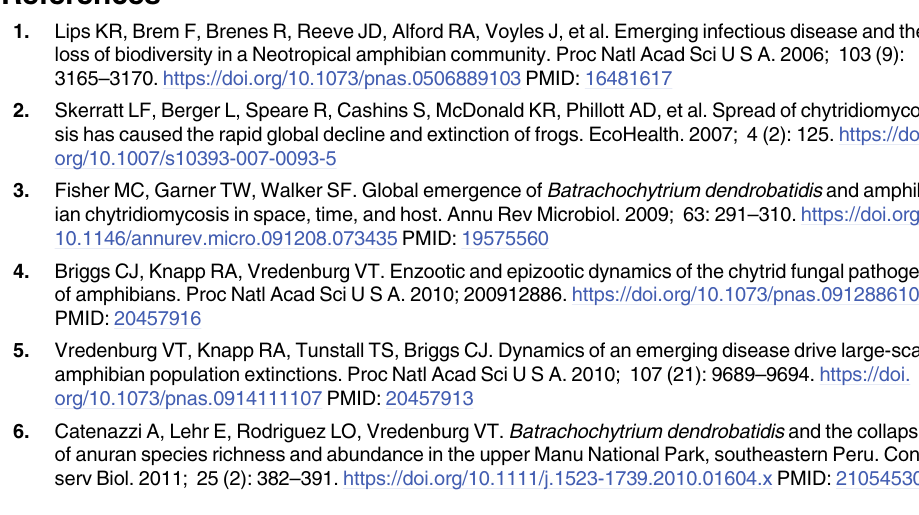
S4 Table. ENMeval models results. S5 Table. Variable contributions to Bsal distribution model. S6 Table. Salamander species of Mexico, range, IUCN status, and relationship with Bsal model and hotspots. Hotspots = pixels with Bsal suitability values greater than 0.5 and more than five salamander species. IUCN status: critically endangered (CR), endangered (E), vulner- able (V), near threatened (NT), least concern (LC), data deficient (DD), and not evaluated (NE). S7 Table. Species present on